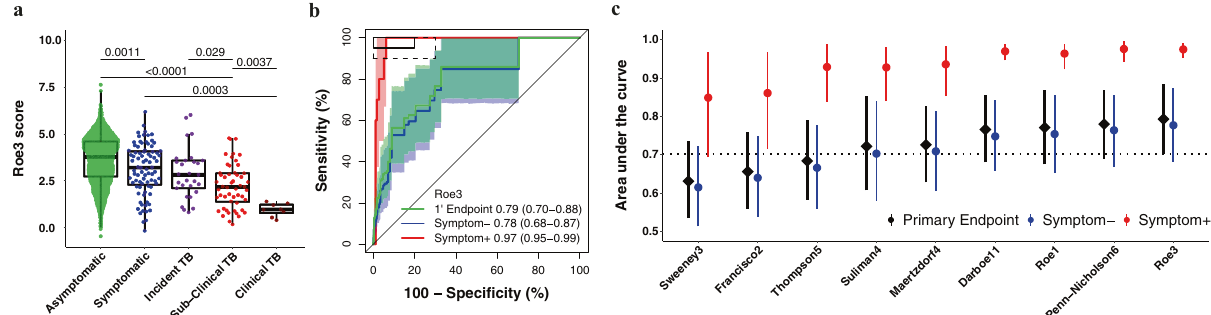
Fig. 2 Parsimonious signature diagnostic performance for prevalent TB and signature score distributions in people without HIV. Representative ( a ) box-and-whisker plot and ( b ) receiver operating characteristic (ROC) curve of the parsimonious signature with the best diagnostic performance (Roe3 signature) in the CORTIS-01 study of people without HIV. Box-and-whisker plots and ROC curves for the other signatures are in the Supplementary Information (Fig. S3). The box-and-whisker plot depicts Roe3 signature score (measured at enrolment) distribution by symptom status (each dot represents a participant) in asymptomatic ( n = 2570) and symptomatic ( n = 83) participants with no TB, participants who progressed to incident TB ( n = 29), and participants with prevalent subclinical (asymptomatic; n = 52) and clinical (symptomatic; n = 8) TB. Prevalent and incident TB comprised all primary endpoint cases. Symptoms were recorded at the time of enrolment for participants without TB and those with prevalent TB. p -values for comparison of median signature scores between groups in the box-and-whisker plot were calculated with the Mann – Whitney U test and corrected for multiple comparisons by use of the Benjamini – Hochberg Procedure 39 . Boxes depict the IQR, the midline represents the median, and the whiskers indicate the IQR ± (1.5 × IQR). The ROC curve depicts diagnostic performance (area under the curve, AUC, with 95% CI) of the Roe3 signature for the primary endpoint (1 ’ Endpoint), i.e. TB diagnosed on two or more liquid culture-positive or Xpert MTB/RIF-positive sputum samples. The ROC curve shows participants with symptomatic clinical prevalent TB versus symptomatic controls (Symptom + ), and participants with asymptomatic, subclinical prevalent TB versus asymptomatic controls (Symptom – ). The shaded areas represent 95% CIs. The solid box depicts the optimal criteria (95% sensitivity and 80% speci fi city) and the dashed box depicts the minimal criteria (90% sensitivity and 70% speci fi city) set out in the WHO Target Product Pro fi le for a triage test 20 . c Summary of signature diagnostic performance in the order of primary endpoint AUC estimates. The diagnostic AUC estimates in symptomatic and asymptomatic participant sub-groups are also shown. The midline indicates the AUC estimate, the error bars indicate the 95% CIs, and the black dotted line indicates the lower bound of the 95% CI for the best performing signature for the primary